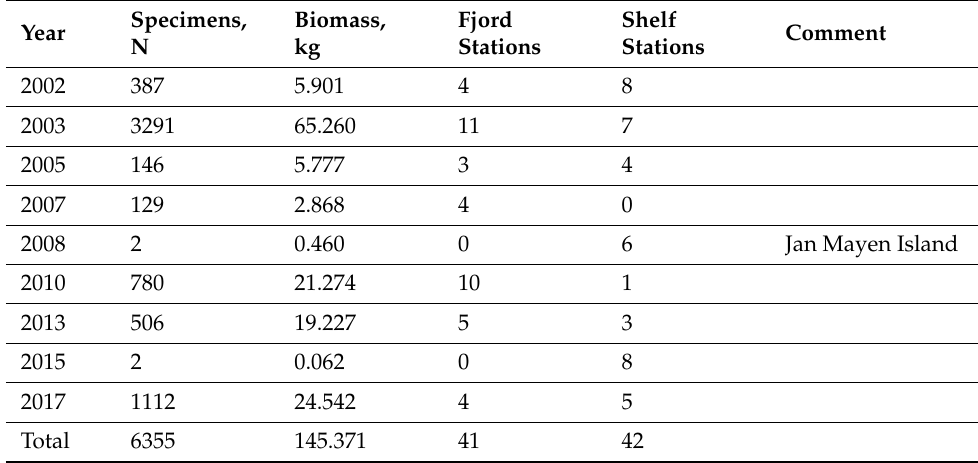
Table 1. Number and biomass of ice cod Arctogadus glacialis sampled in fjords and on the shelf in Northeast Greenland during years 2002–2017. A total of 83 stations were sampled during the survey period, cf. Figure